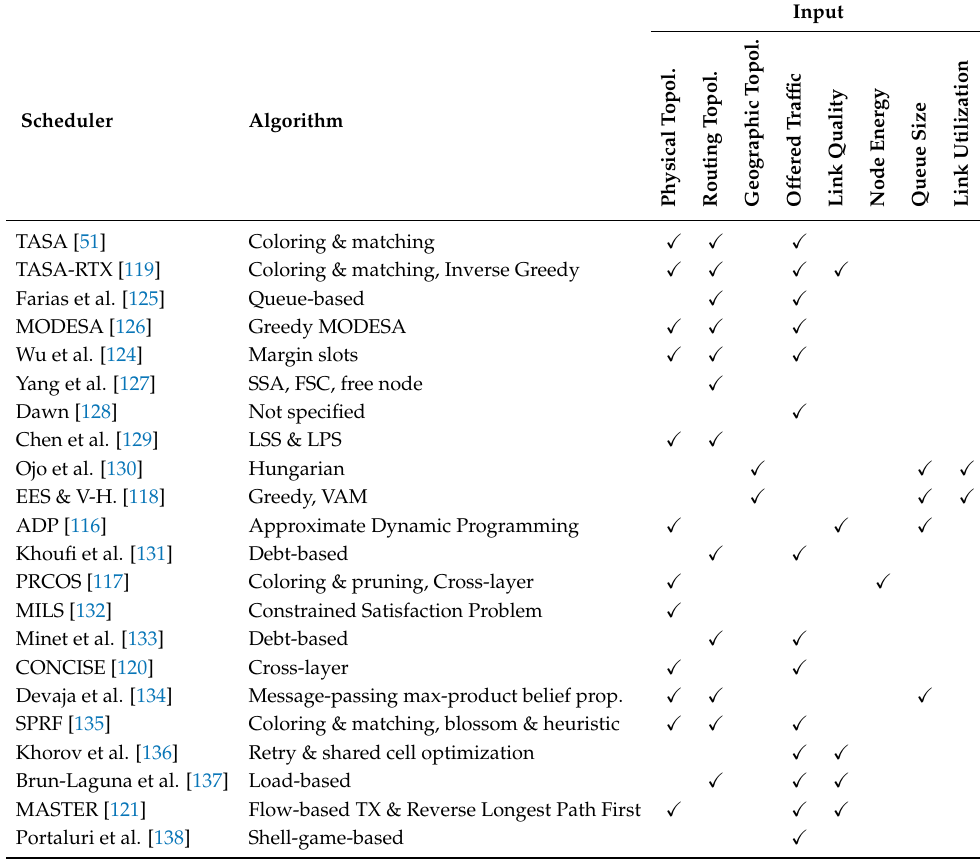
Table 7. Components of centralized TSCH